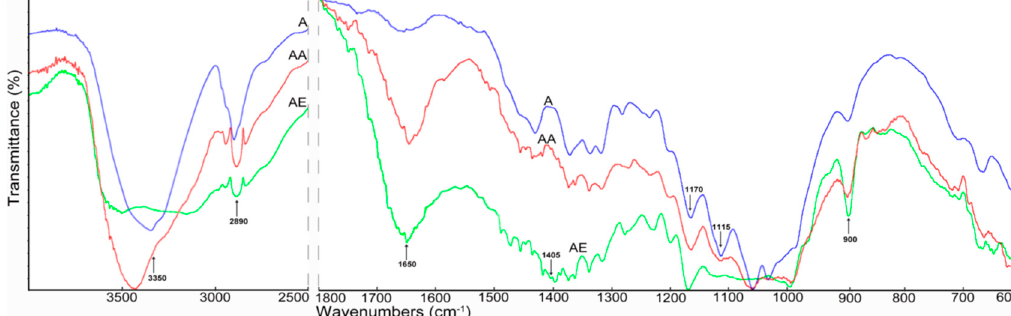
Figure 1. FTIR spectra of (A) enzyme-pretreated Avicel cellulose, (AA) enzyme-pretreated Avicel cellulose treated with AmimCl, and (AE) enzyme-pretreated Avicel cellulose treated with EmimOAc.